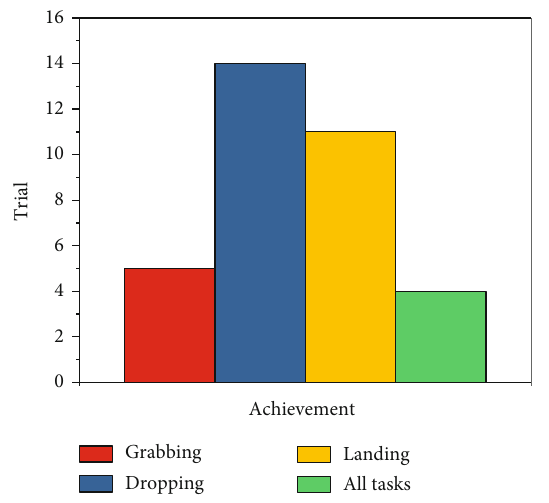
Figure 11: Results of the trials.